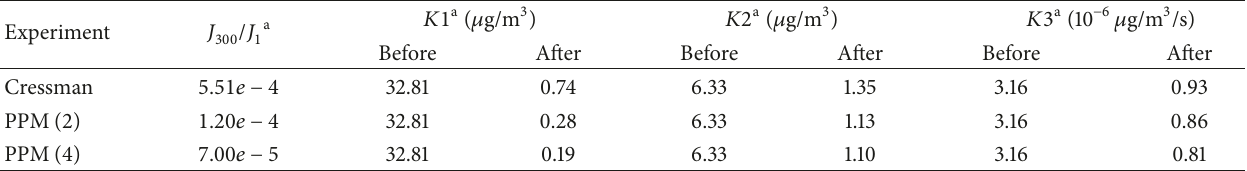
Table 1: Error statistics of different interpolation matched optimal IPs distribution scheme.